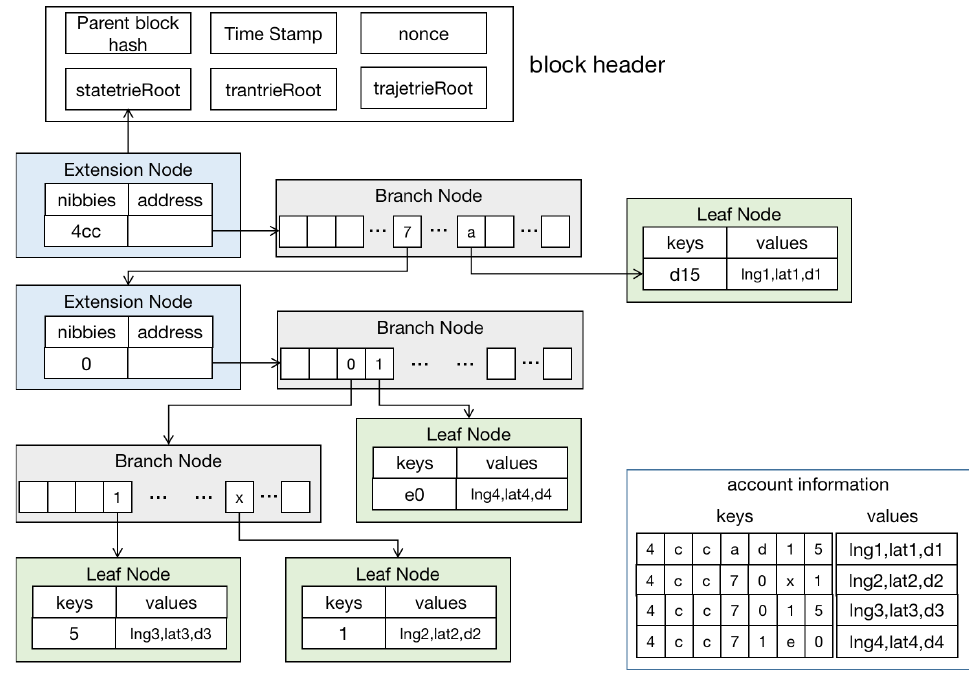
Figure 3. Verkle Patricia Trie.